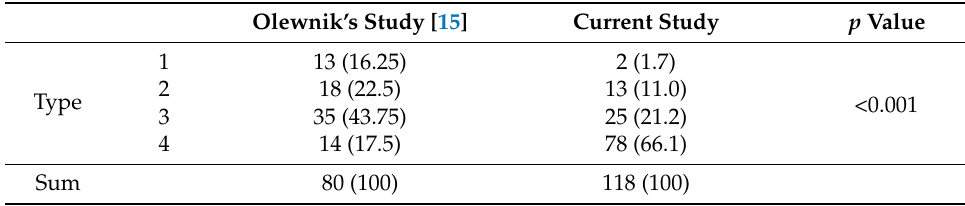
Table 3. Comparison of distribution of types between two classifications.